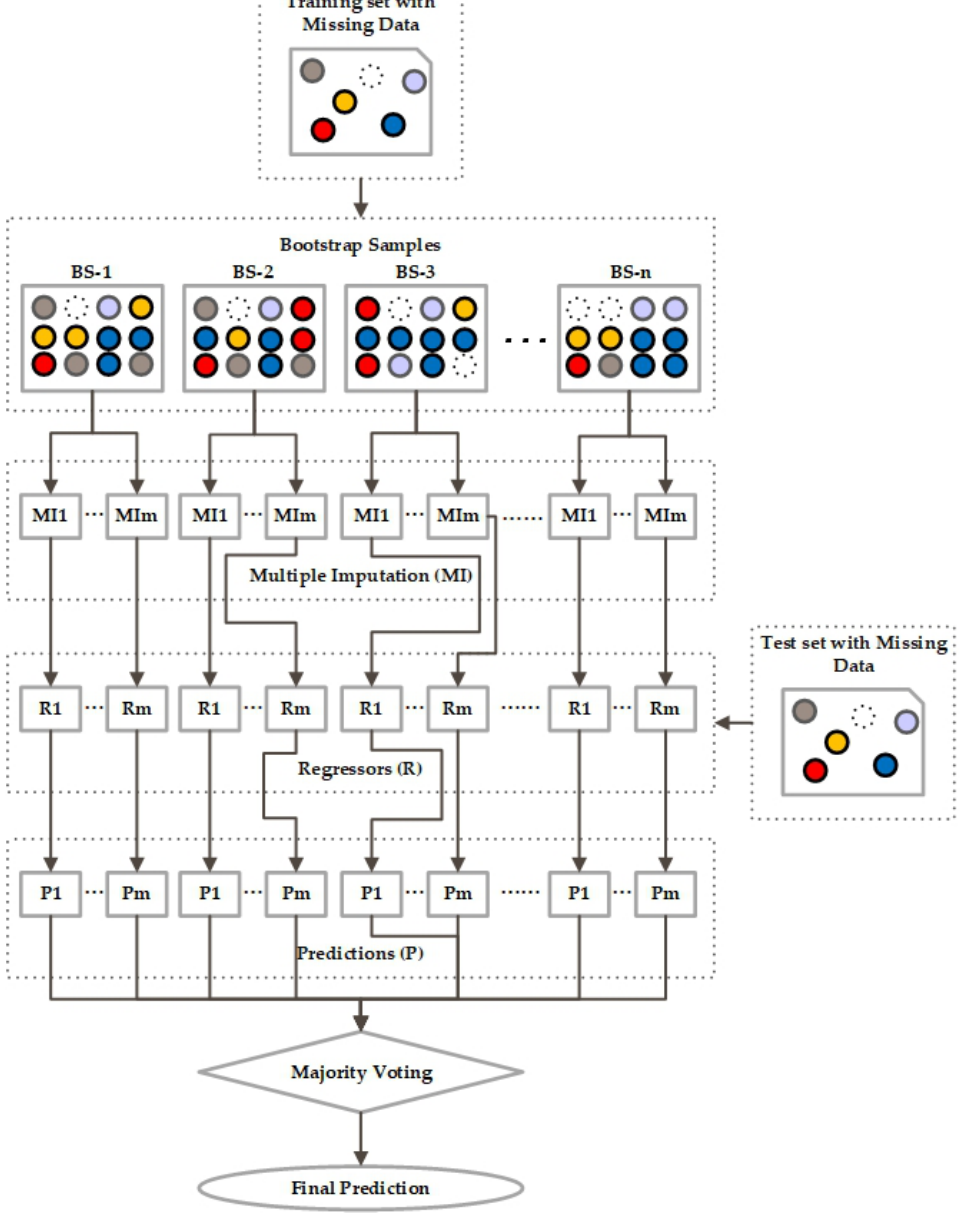
Figure 3. Architecture of Bagging